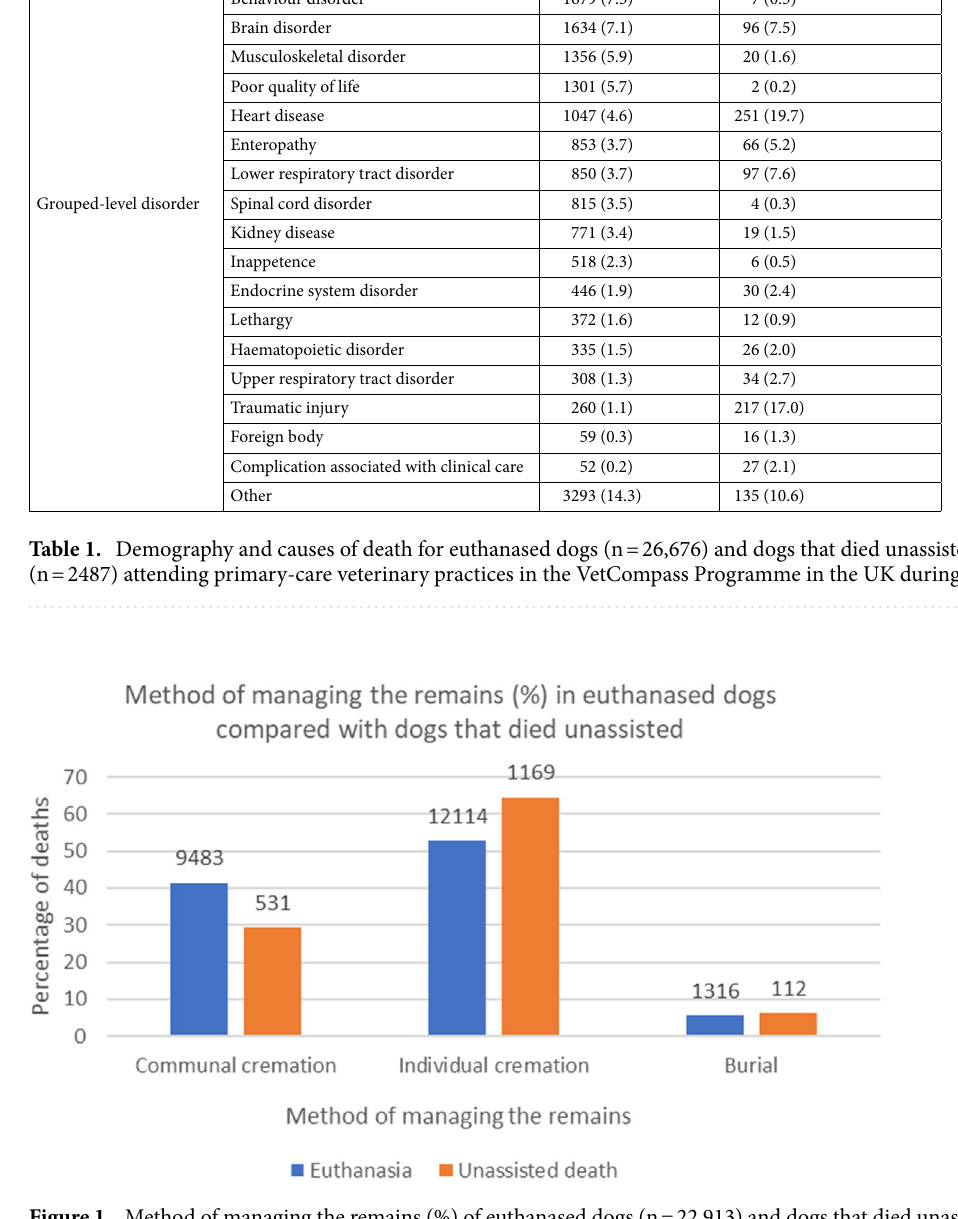
Figure 1. Method of managing the remains (%) of euthanased dogs (n = 22,913) and dogs that died unassisted (n = 1812) attending primary-care veterinary practices in the VetCompass Programme in the UK during 2016. The count of dogs in each category is given at the top of each